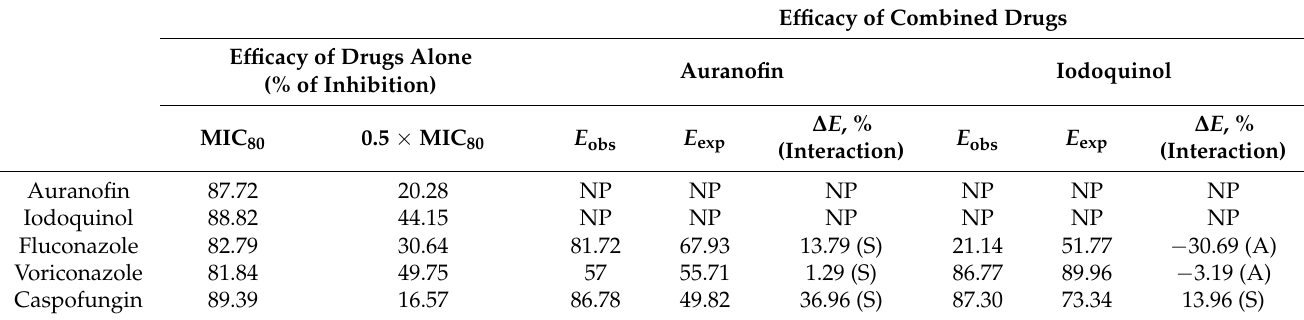
Table 4. Antifungal activity of auranofin, iodoquinol, fluconazole, voriconazole and caspofungin—Alone and in combina- tions according to the Bliss independence